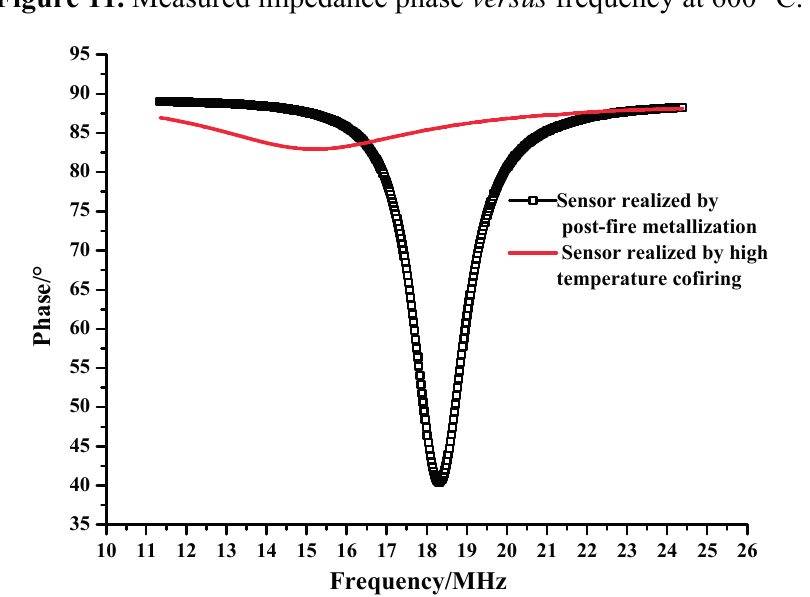
Figure 11. Measured impedance phase versus frequency at 600